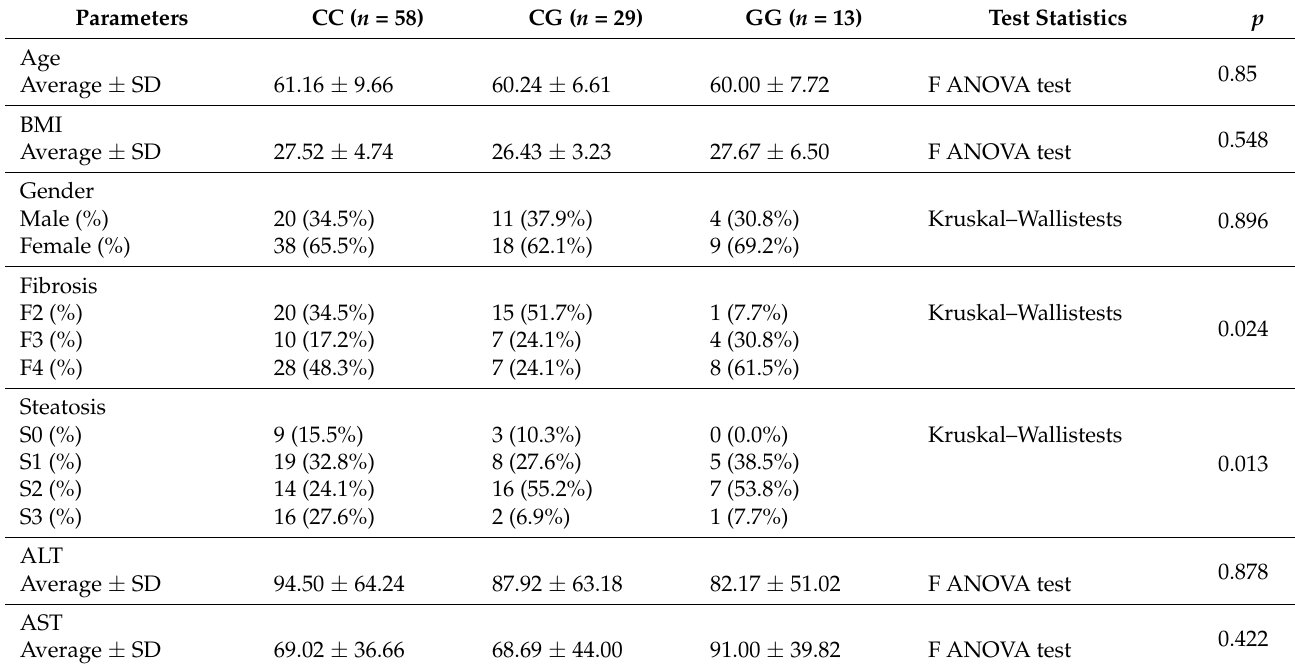
Table 2. Baseline characteristics according to PNPLA3